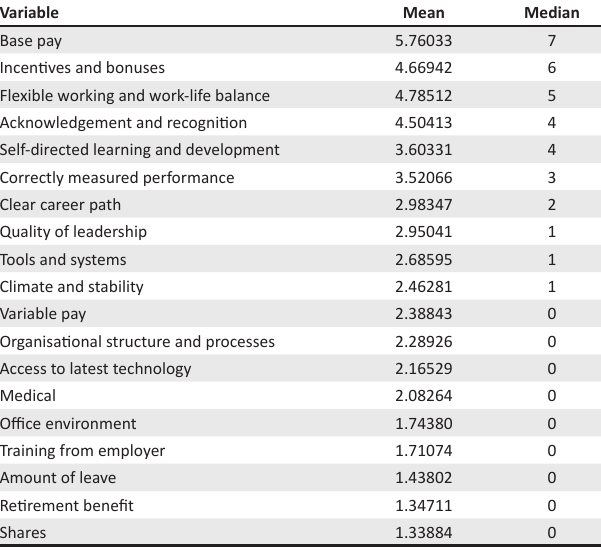
TABLE 8: Summary of rank scores for